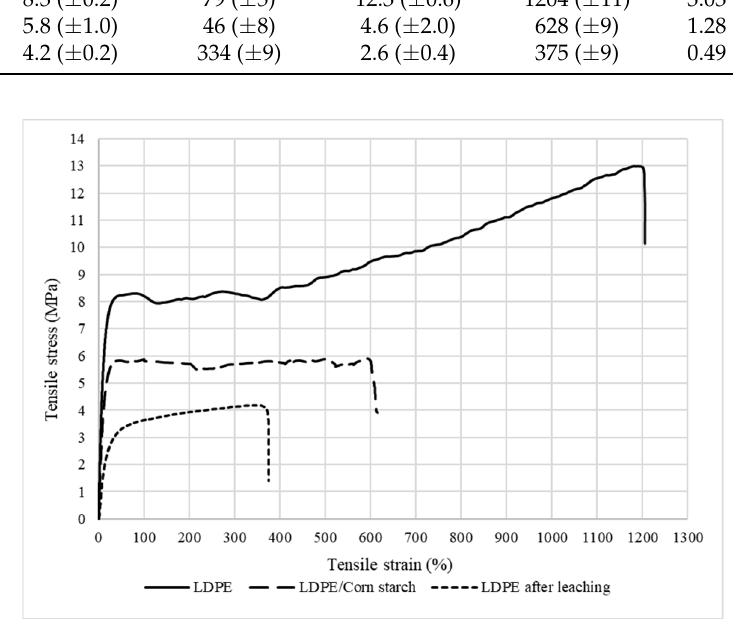
Figure 10. Tensile stress–strain curves for the different samples. Table 4. Mechanical properties in tension: tensile stress at yield ( σ 0 ), strain at yield ( ε 0 ), tensile stress at break ( σ 𝑚𝑎𝑥 ), strain at break ( ε 𝑚𝑎𝑥 ), energy at break ( 𝐸𝑛 ), and Young’s modulus ( E ).